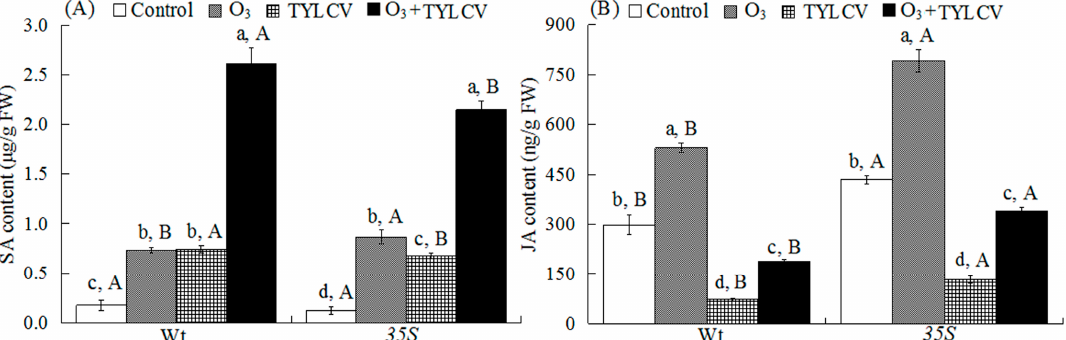
Figure 3. Concentrations of ( A ) salicylic acid (SA); and ( B ) jasmonic acid (JA) in the two tomato genotypes (Wt and 35S ) grown under ambient and elevated O 3 with and without TYLCV infection